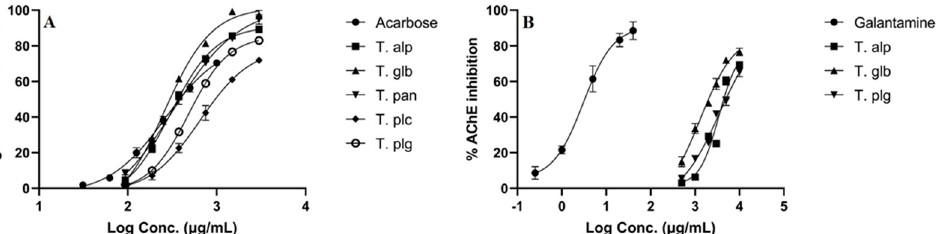
Figure 4. The concentration (expressed as logC, in μ g/mL)-dependent enzyme-inhibitory activity of Thymus extracts against α -glucosidase ( A ) and acetylcholinesterase (AChE) ( B ). Acarbose and galantamine were used as reference substances in anti- α -glucosidase and anti-AChE assays, respectively.